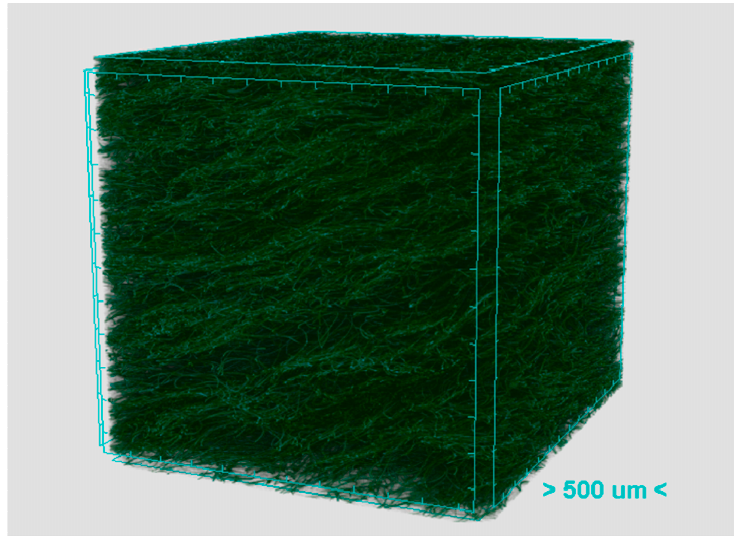
Figure 4. Polyester nonwoven samples ( a ) and cross-sectional macroscopic images (b).